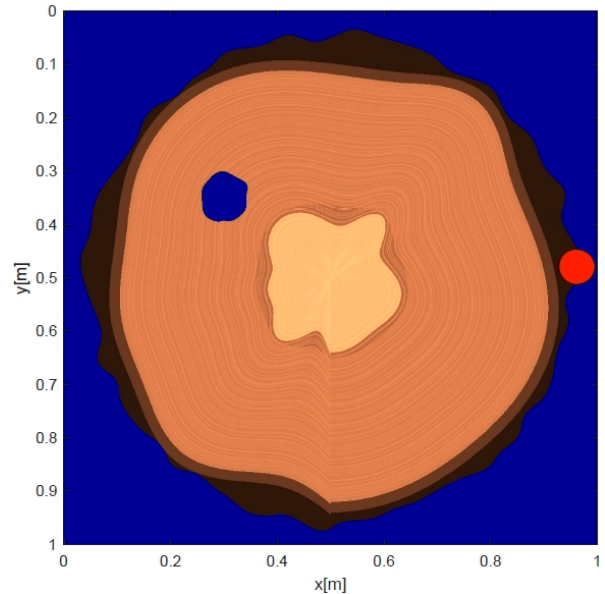
Figure 3. The circular hardwood trunk scenario investigated using FDTD numerical modelling. The starting point of the measurements, taken clockwise, is represented by the red circle.